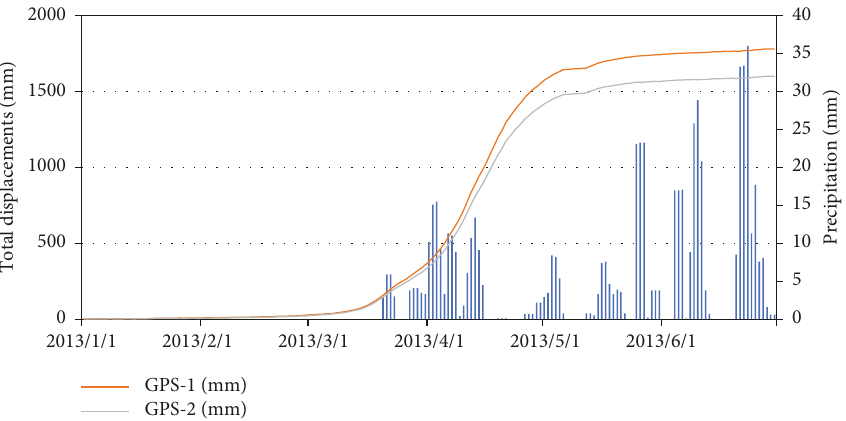
Figure 10: Total displacements measured by GPS versus precipitation in accumulative 3 days.